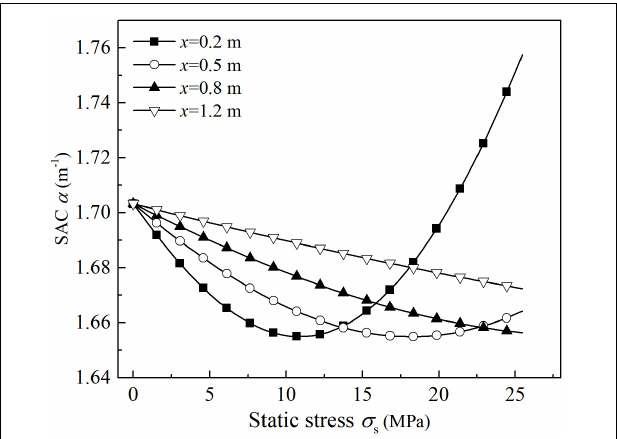
FIGURE 3 | Variation in spatial attenuation coefficient versus static